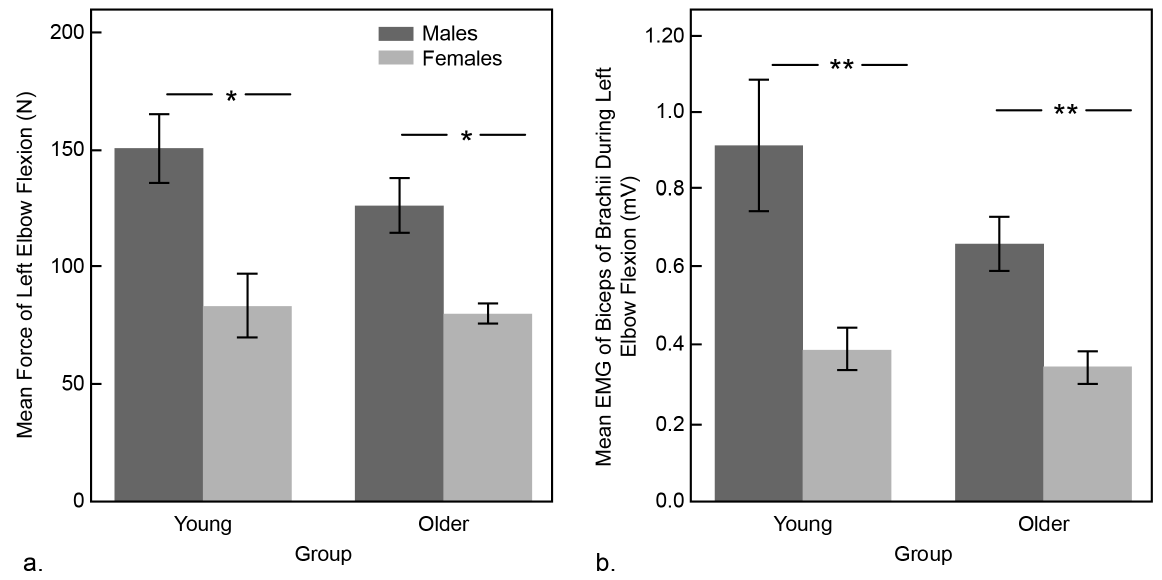
Figure 1. Effects of age and gender on strength. Findings of two-way analyses of variance exploring effect of age group and gender on (a) mean force of left elbow flexion and (b) mean EMG of biceps brachii. Older adults were not significantly weaker than young, but females were weaker than males in both age groups (* p # 0.05; ** p # 0.001).